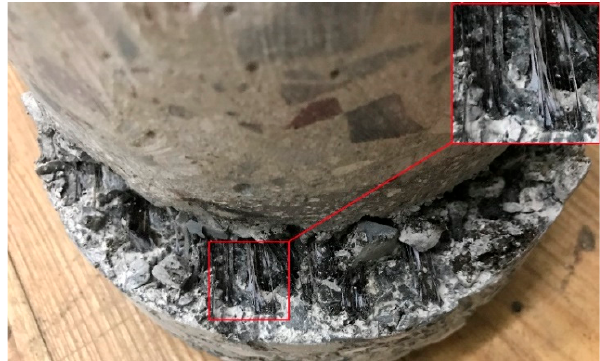
Figure 11. The interface of fracture after the shearing test.